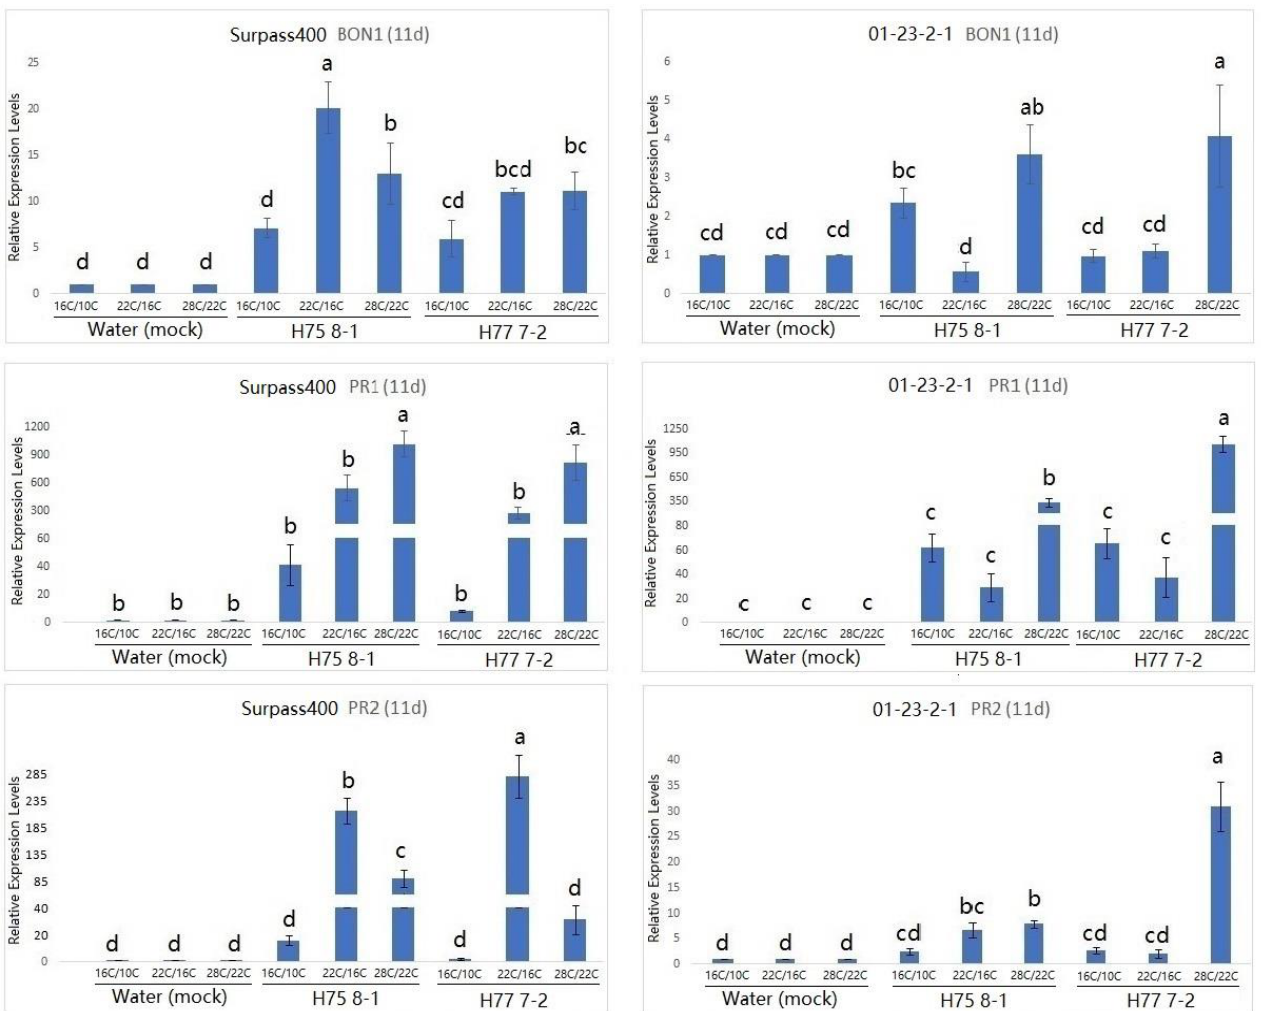
Figure 4. Gene expression of BONZAI1 (BON1) , PATHOGENESIS-RELATED ( PR)1 and PATHOGENESIS-RELATED ( PR)2 (in B. napus ) in the regulation of hormonal signals at 11 dpi from Surpass400 and 01-23-2-1 inoculated by the blackleg isolates HCRT75 8-1 and HCRT77 7-2. The inoculated plants were exposed to three temperature treatments: 16 °C/10 °C, 22 °C/16 °C and 28 °C/22 °C (day/night: 16 h/8 h). The levels of the bars are the expression levels obtained from the inoculated cotyledons (inoculated by H75 8-1 and H77 7-2) compared to the cotyledons inoculated with water (assuming that the expression of each studied gene in the cotyledons inoculated with water is 1). Error bars represent standard error of the mean. Different lowercase letters suggest the significant differences among mean values (Fisher’s Least Significant Difference; p < 0.05). The results are based on three replicates in three independent experiments.